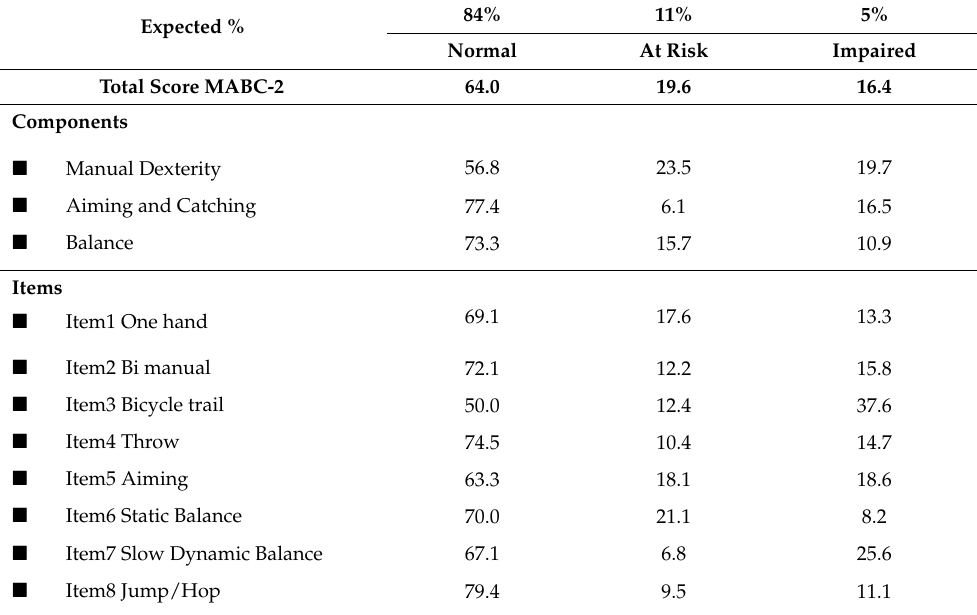
Table 3. Percentage per motor skill classification based on MABC-2 total scores, component and item scores.